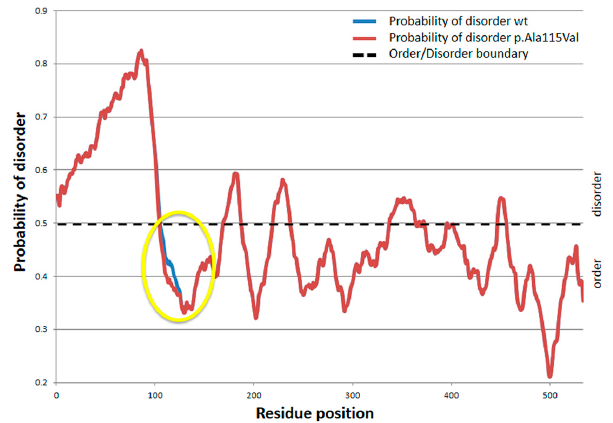
Figure 2. Per-residue disordered prediction of wild-type NAGS protein versus the p.Ala115Val mutated form. The wild type (in blue) and p.Ala115Val variant (in red) amino acid NAGS sequences were analysed by RONN software. For each amino acid, the probability of disorder score has been assigned. The black dotted line indicates the order/disorder boundary. The p.Ala115Val substitution occurs in a region of the protein that is estimated by RONN analysis to be below the order/disorder boundary, in the ordered predicted area. The single amino acid substitution p.Ala115Val results in a decrease in the probability of disorder that affects the mutated amino acid and its neighbouring region (between residues 93 and 133, highlighted in the figure in the yellow circle).